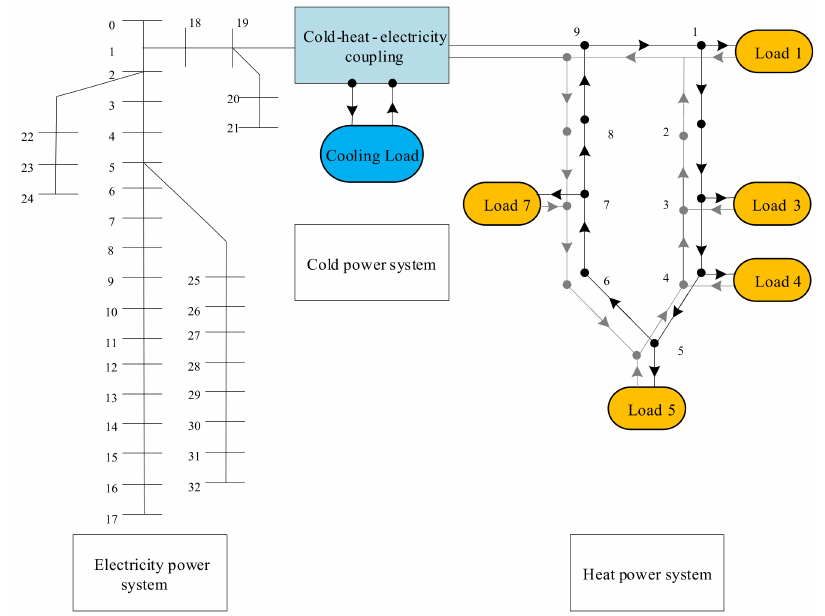
Figure 1. Topology of distributed energy